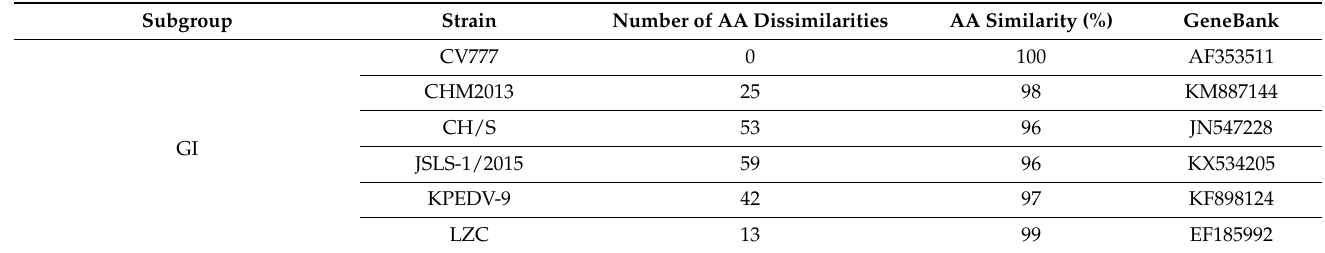
Table 1. Similarity in the amino acid residues of the S protein of different PEDV strains (CV777 was used as a